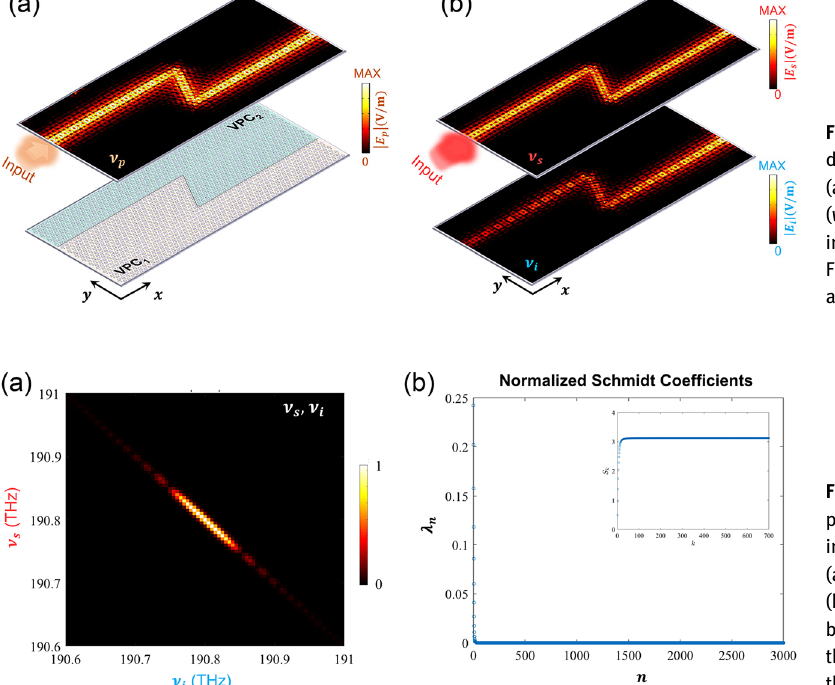
Figure 6: FWM interactions in VPCs with different interfaces.